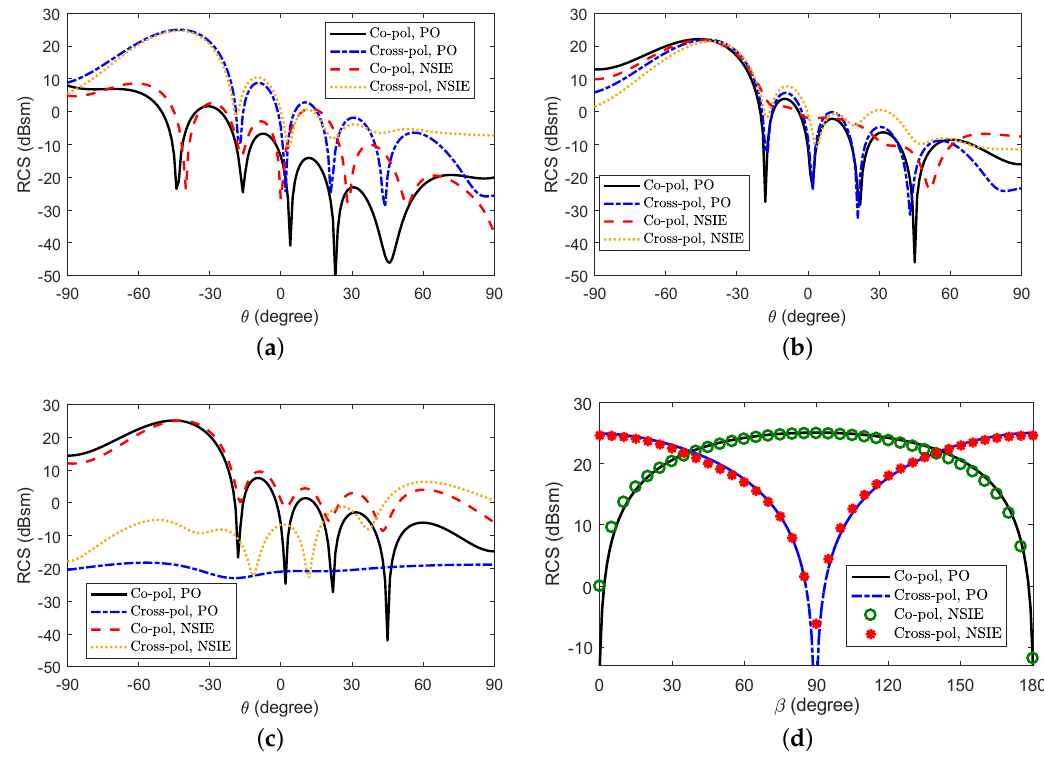
Figure 6. Bistatic RCS of the disk in Figure 1 with T s = T d = 1 illuminated by a plane wave with θ i = 45 ◦ at the frequency of 300 MHz. The results are shown in the x - z plane. ( a ) β = 0 ◦ . ( b ) β = 38.7 ◦ . ( c ) β = 90 ◦ . ( d ) Bistatic RCS at θ = − 45 ◦ as a function of β